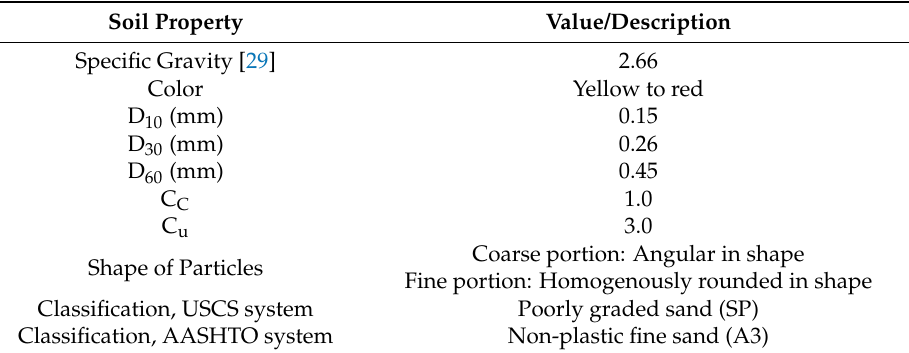
Figure 1. Location of the waste sand used in this study as base course material, Riyadh Road, Saudi Arabia. Table 1. Summary of the physical properties of the waste